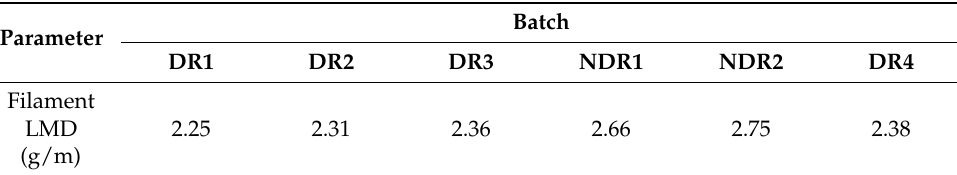
Table 10. Summary results of filaments linear mass density (LMD).